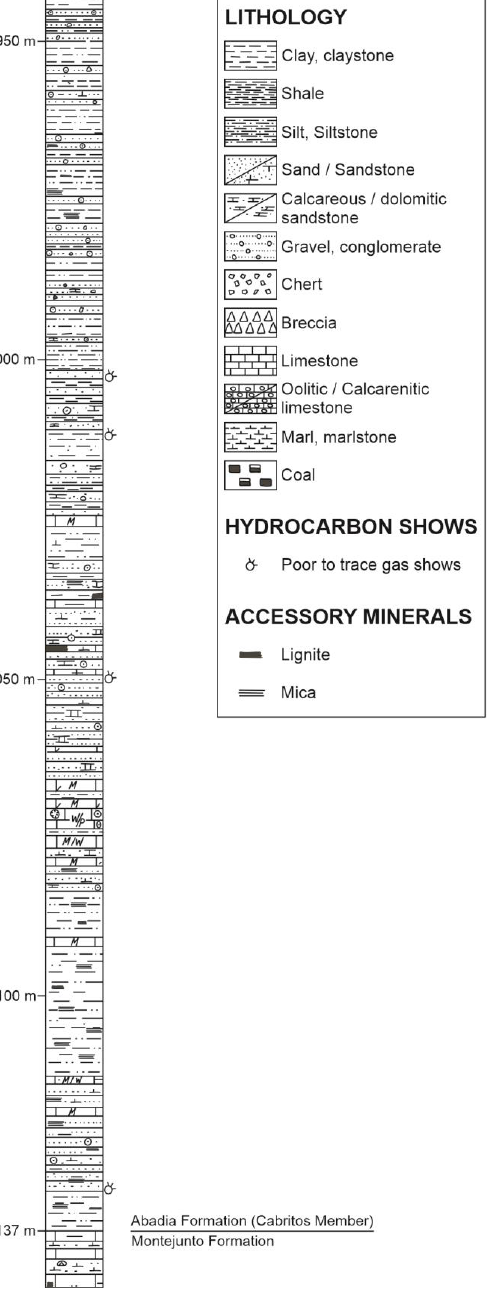
Figure 15. The 204 m interval (from 940 m to 1144 m depth) of the composite profile of the Benfeito-1 (Bf-1) exploratory well. This range clearly shows various levels of turbidite sandstones from the Cabritos Member. Several hydrocarbon shows were detected in these sandstones, including four at this interval, attesting to the effectiveness of the Cabaços-Abadia petroleum system, adapted from Ref.